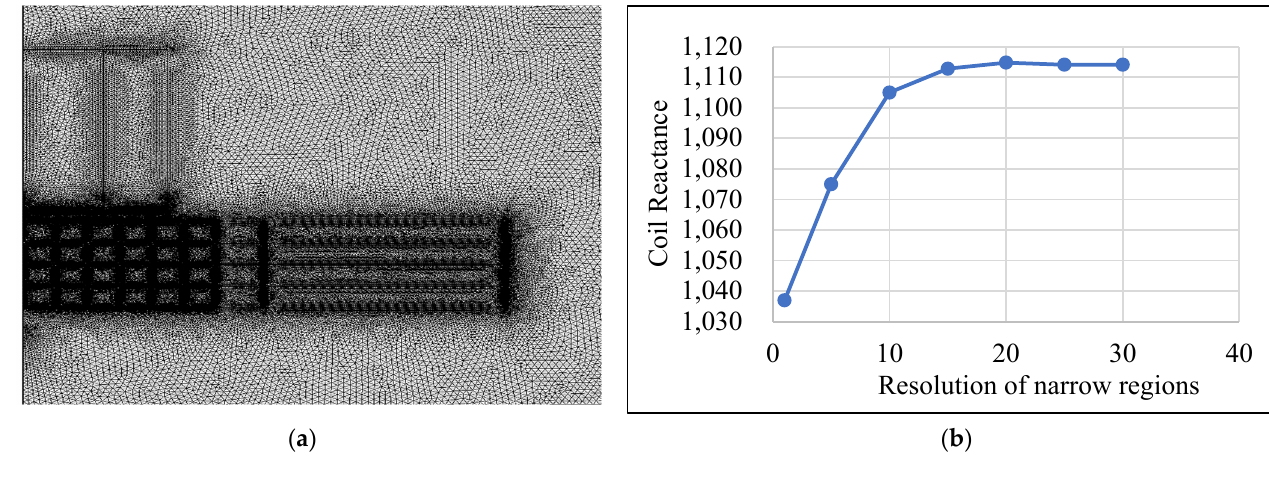
Figure 6. ( a ) The adaptive mesh used for modeling the coil, and ( b ) the convergence of coil reactance with the increasing resolution of narrow regions.